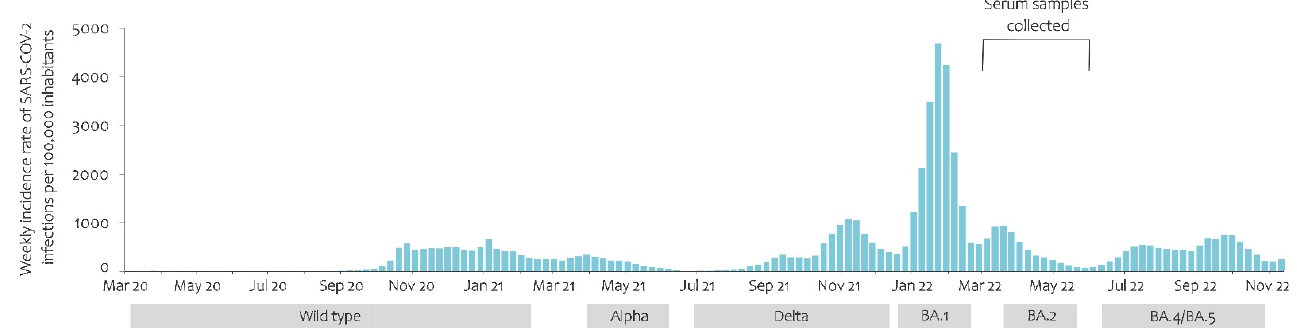
Figure 1. SARS-CoV-2 infection incidence rate (per 100,000) and variant predominance in Slovenia from the first detected case (4 March 2020) to 14 November 2022.